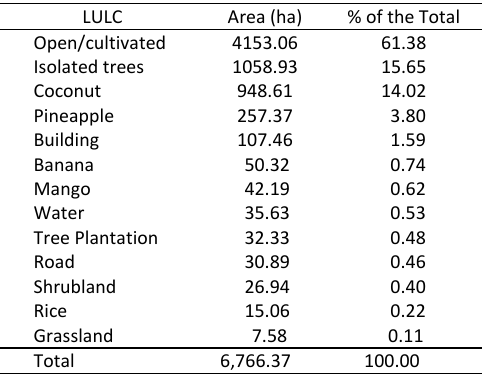
Table 1: LULC distribution in the watershed LULC Area (ha) % of the Total